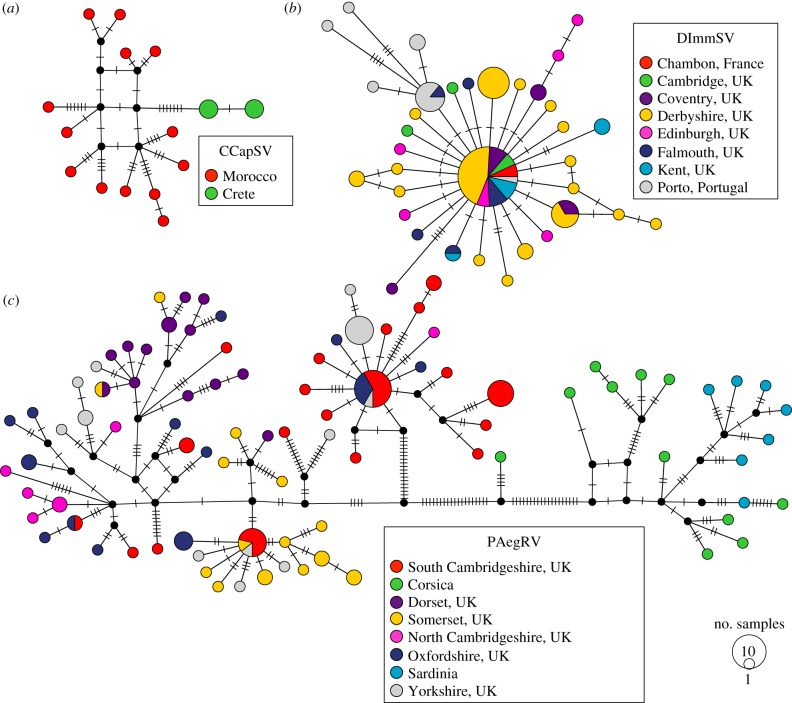
Median joining phylogenetic network of sequences from the three viruses. The colours represent the different locations samples were collected from, the size of the node represents the number of samples with that sequence and the dashes on branches show the number of mutations between nodes. (a) Nineteen CCapSV sequences, (b) 87 DImmSV sequences and (c) 130 PAegRV sequences. Phylogenetic trees of each of the viruses are also available (https://dx.doi.org/10.6084/m9.figshare.3437723.v1).